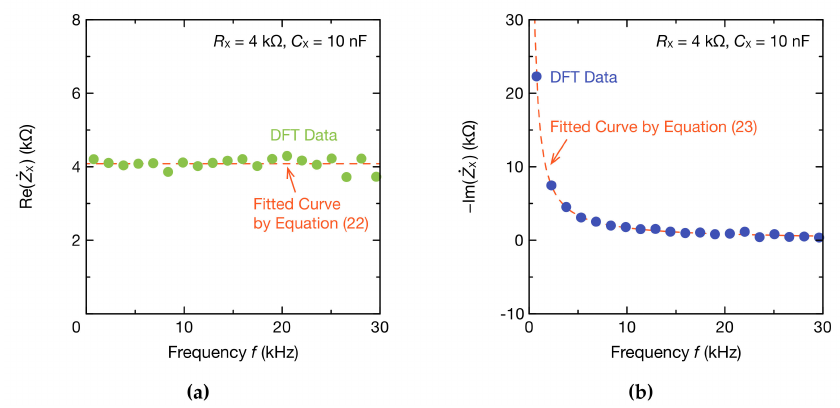
. Z X ) ; and ( b ) imaginary part Im (